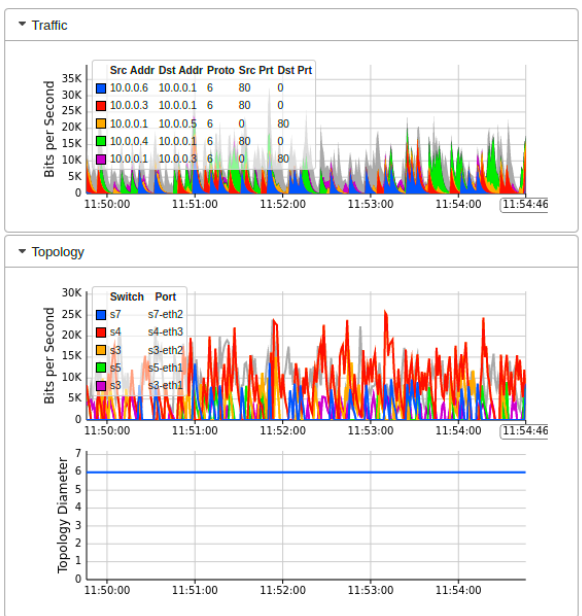
Figure 7. Mininet performance dashboard during real-time normal traffic (T1).